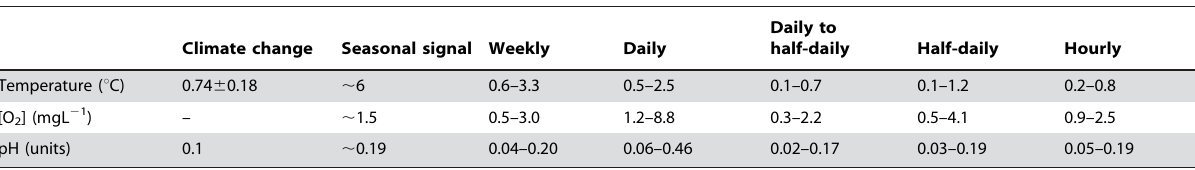
Table 2. Amplitude of fluctuations at different frequency